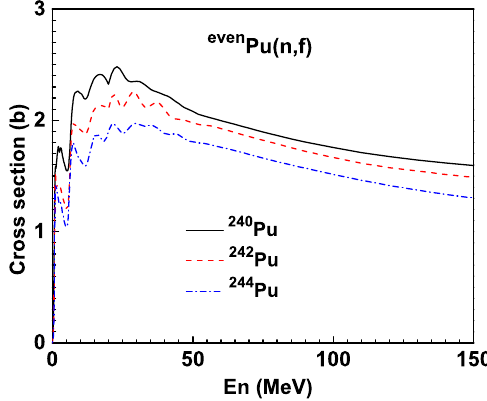
Figure 4. Calculated result of 242 Pu(n, γ ) reaction cross section (solid line) compared with the experimental data and the evalu- ated data from JENDL-4 / HE (dashed line).